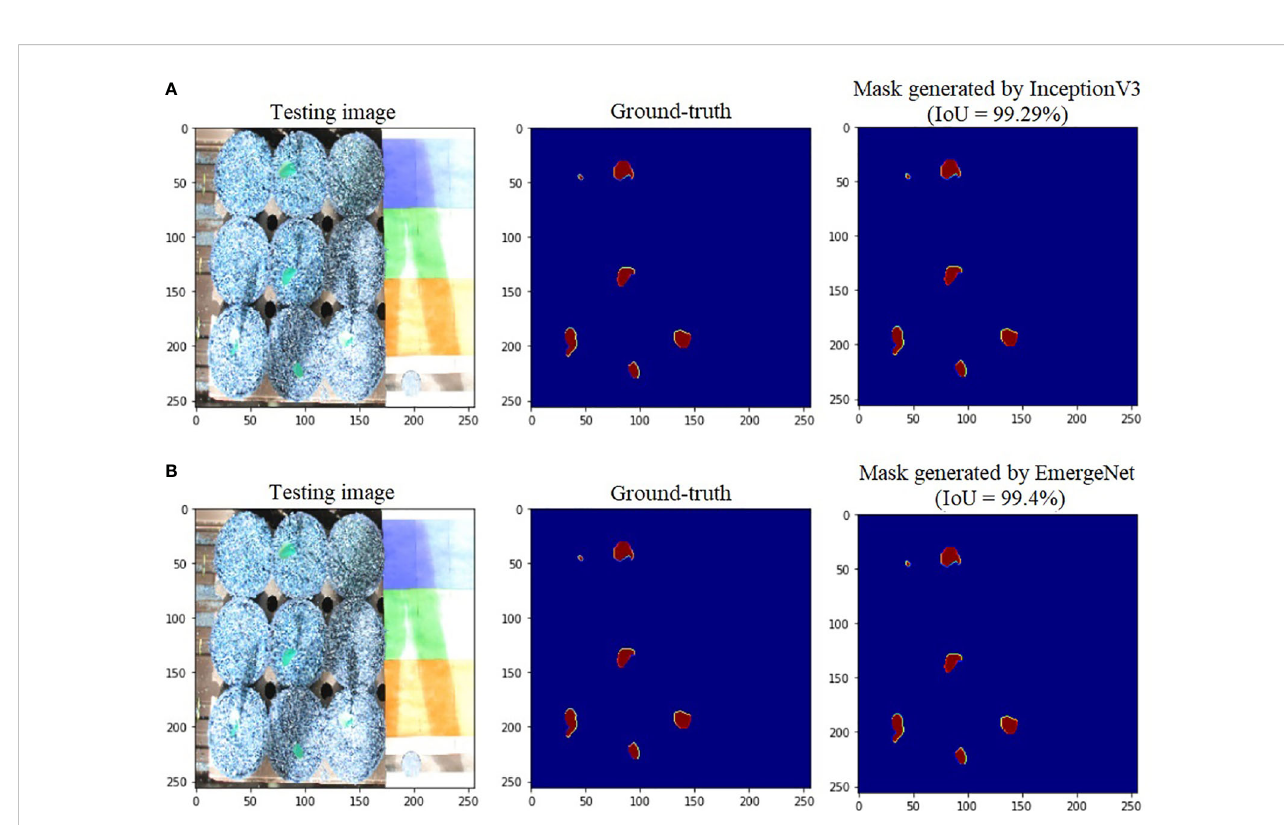
FIGURE 9 Illustration of segmentation performance on a test image from UNL-MED by (A) InceptionV3 and (B)